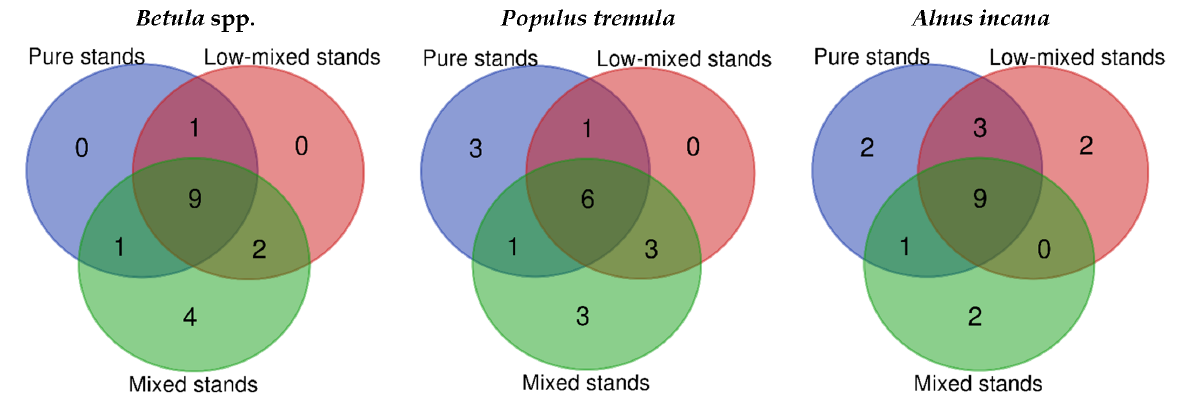
Figure 3. Venn diagram indicating the diversity of the selected predominant undergrowth species